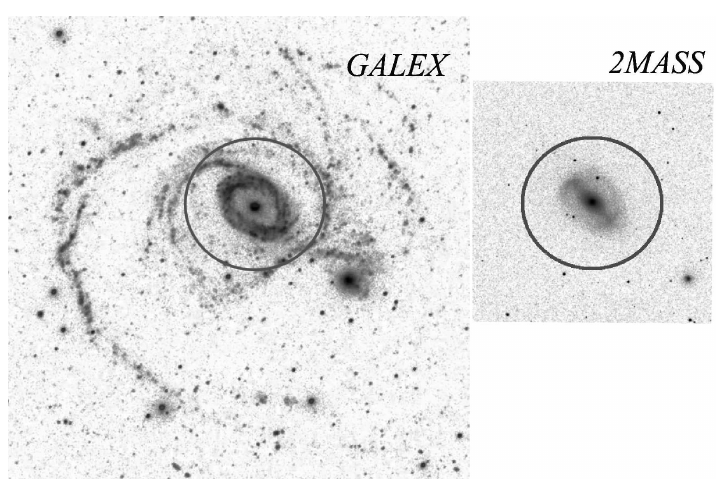
Fig. 1. UV (left) and NIR (right) images of NGC 1512. The black circle shows the optical size R opt of the